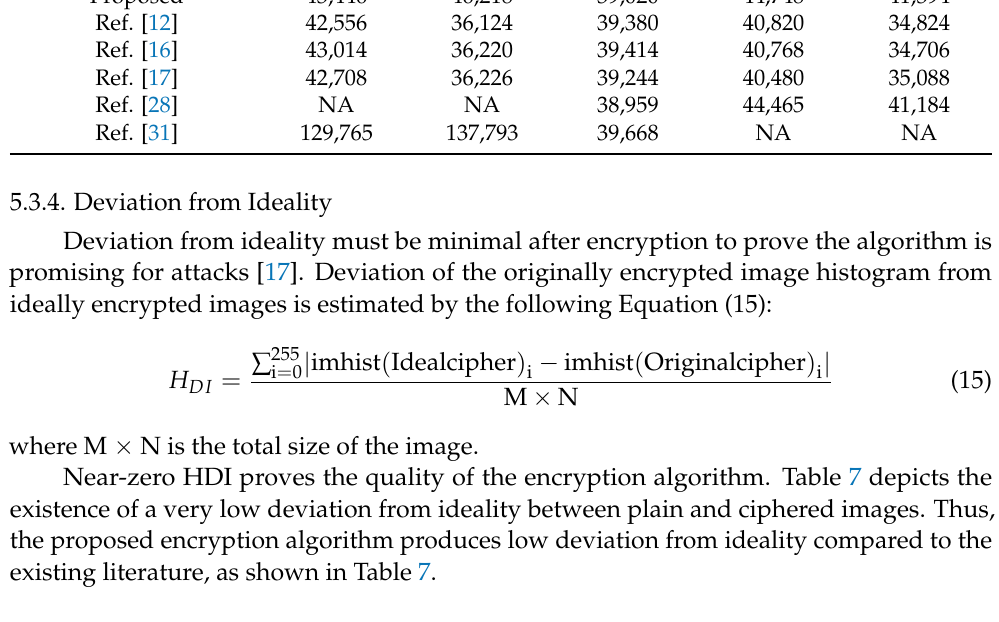
Table 7. Deviation from